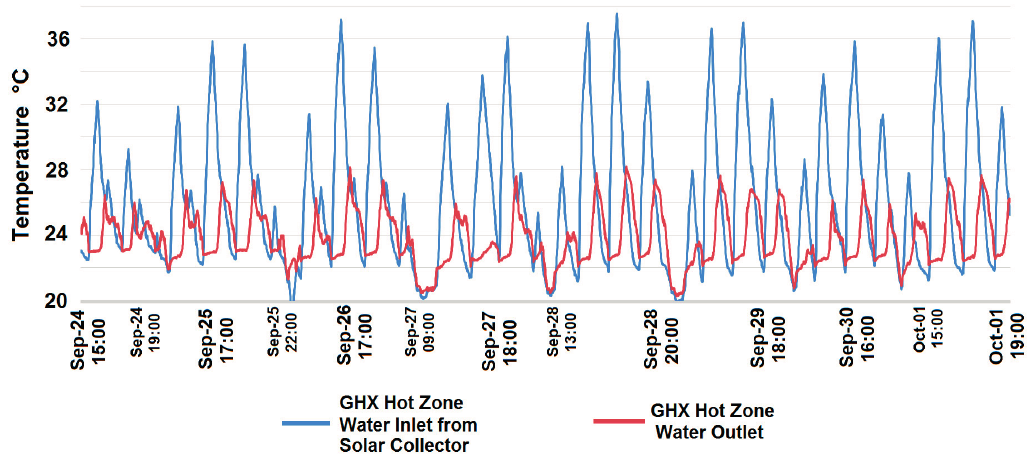
Figure 20. Temperature at the water inlet and outlet sensors of the ground heat exchanger. Ground heat exchanger temperatures for the hot zone (SSN19_T4), cool zone (SSN54_T4 and SSN66_T4), and cold zone (SSN70_T4), are represented in Figure 21. The square box at